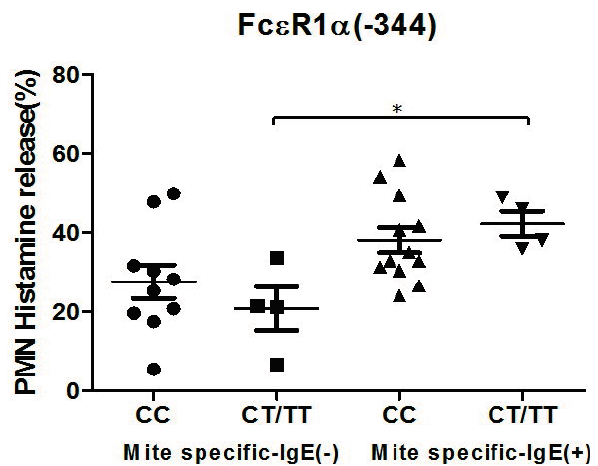
Figure 4. Genetic effect of SNPs of the Fc ε R1 α promoter region (rs2427827, − 344) on histamine release. The PMNs derived from patients with different Fc ε R1 α promoter SNPs were incubated with Der p2 for 30 min, followed by histamine analysis. Values were presented as mean ± SEM. PMNs from patients with mite-specific IgE(+) were incubated with Der p2; there was significantly increased histamine release compared to serum derived from mite specific IgE( − ); * p < 0.05 significance level when comparisons between two groups. 2.6. Genetic Effects of SNPs of the Fc ε R1 α Promoter Region on Cytokine Secretion